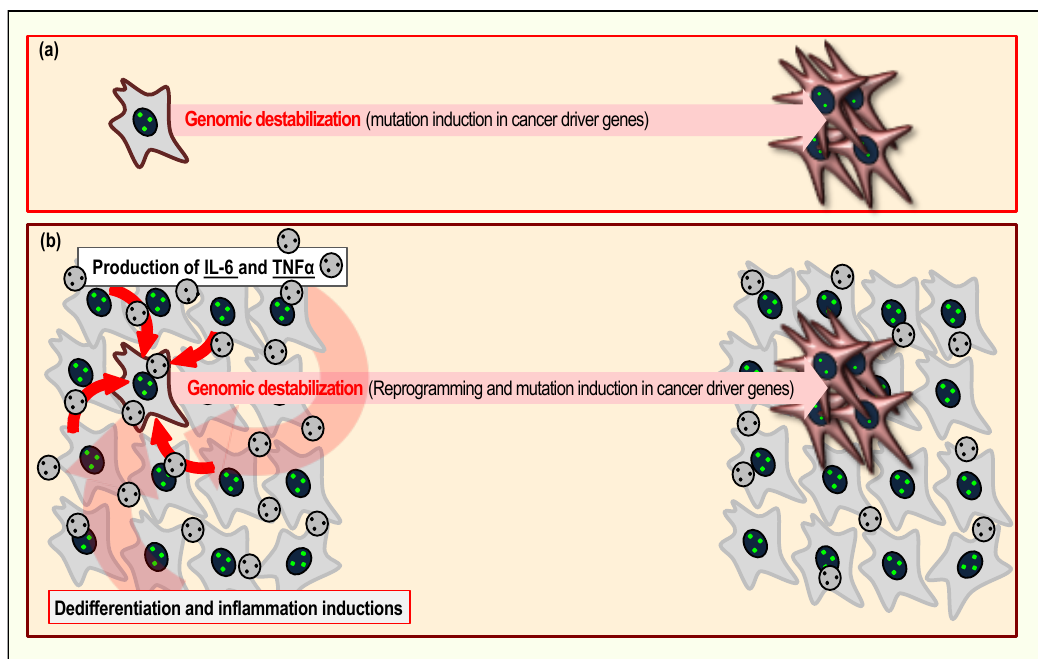
Figure 2. Induction of senescent cells promotes cancer development. Cells in the senescent state can contribute to cancer development in at least two ways. First, under continuous growth stimuli, accumulated DSBs can trigger genomic destabilization, directly promoting immortalization and acquisition of CSC (cancer-stem cell) characteristics, thereby promoting tumor development ( a ). Second, senescent cells often produce factors associated with the senescence-associated secretory phenotype, including TNFα and IL6 ( b ). Secreted TNFα and IL6 induce dedifferentiation and inflammation, further contributing to cancer development.